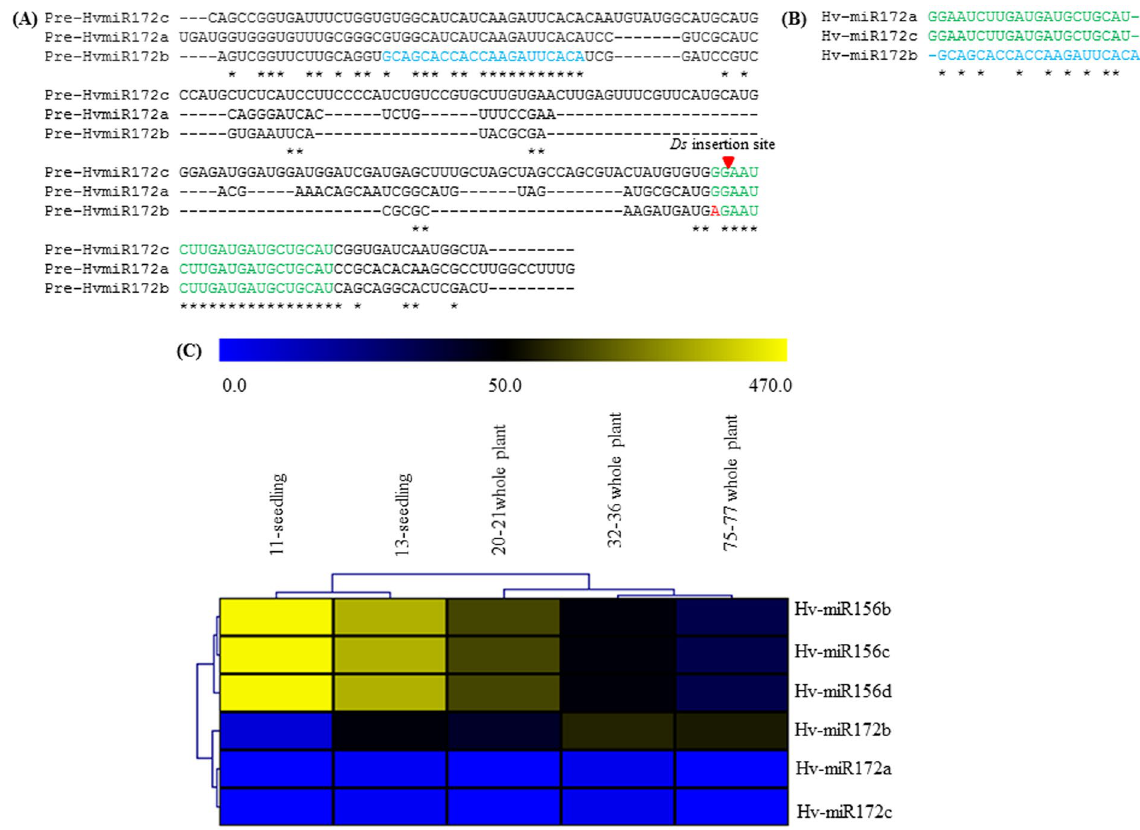
Figure 5. Barley miR172 sequences and expression analysis of miR156 and miR172 family members. ( A ) Alignment of three miR172 (miR172a/b and c) precursor sequences. ( B ) Alignment of three miR172 mature sequences. Green and blue colours differentiate mature sequences of miR172a & c and miR172b respectively. (C) Heat map showing the expression profiling of Hv-miR156b/c/d and Hv-miR172a/b/c. Expression data was obtained from publically available database mirex2.0. Antagonistic expression pattern of miR156 and miR172b was observed during vegetative and reproductive phases of barley. The respective transcripts of miR156 and miR172 has been shown in RPM (reads per million). The red triangle indicates Ds insertion site in miR172c mature